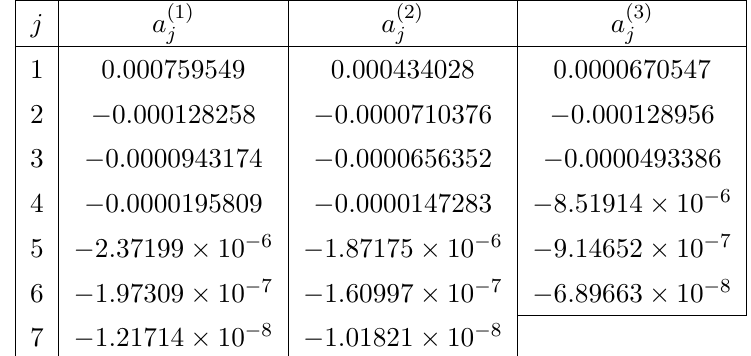
Table 1 . The coefficients a ( i )